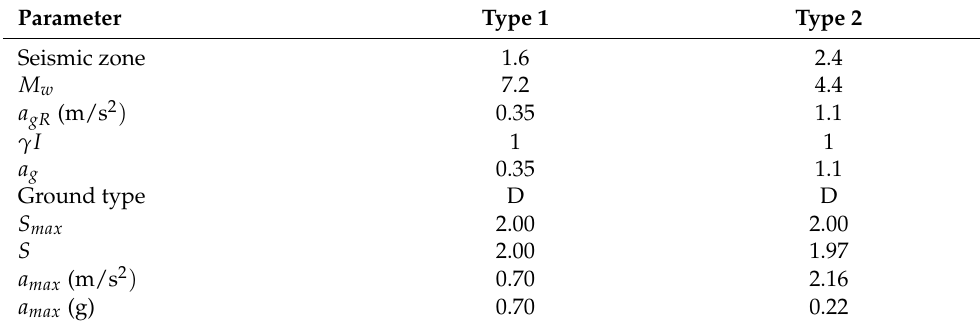
Table 1. Seismic actions of Aveiro